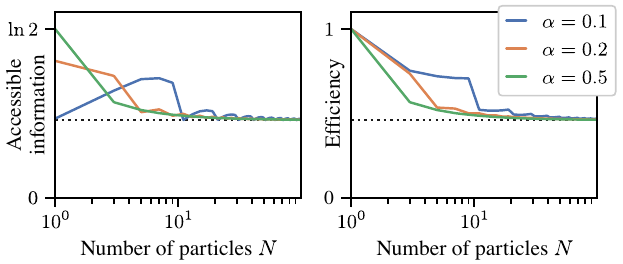
FIG. 12. Left: accessible information I ϕ C acc ð X ; M Þ for the collective flashing ratchet, as a function of N (number of particles) and α (asymmetry). Right: the efficiency of the measurements, I ϕ C acc ð X ; M Þ =I ð X ; M Þ